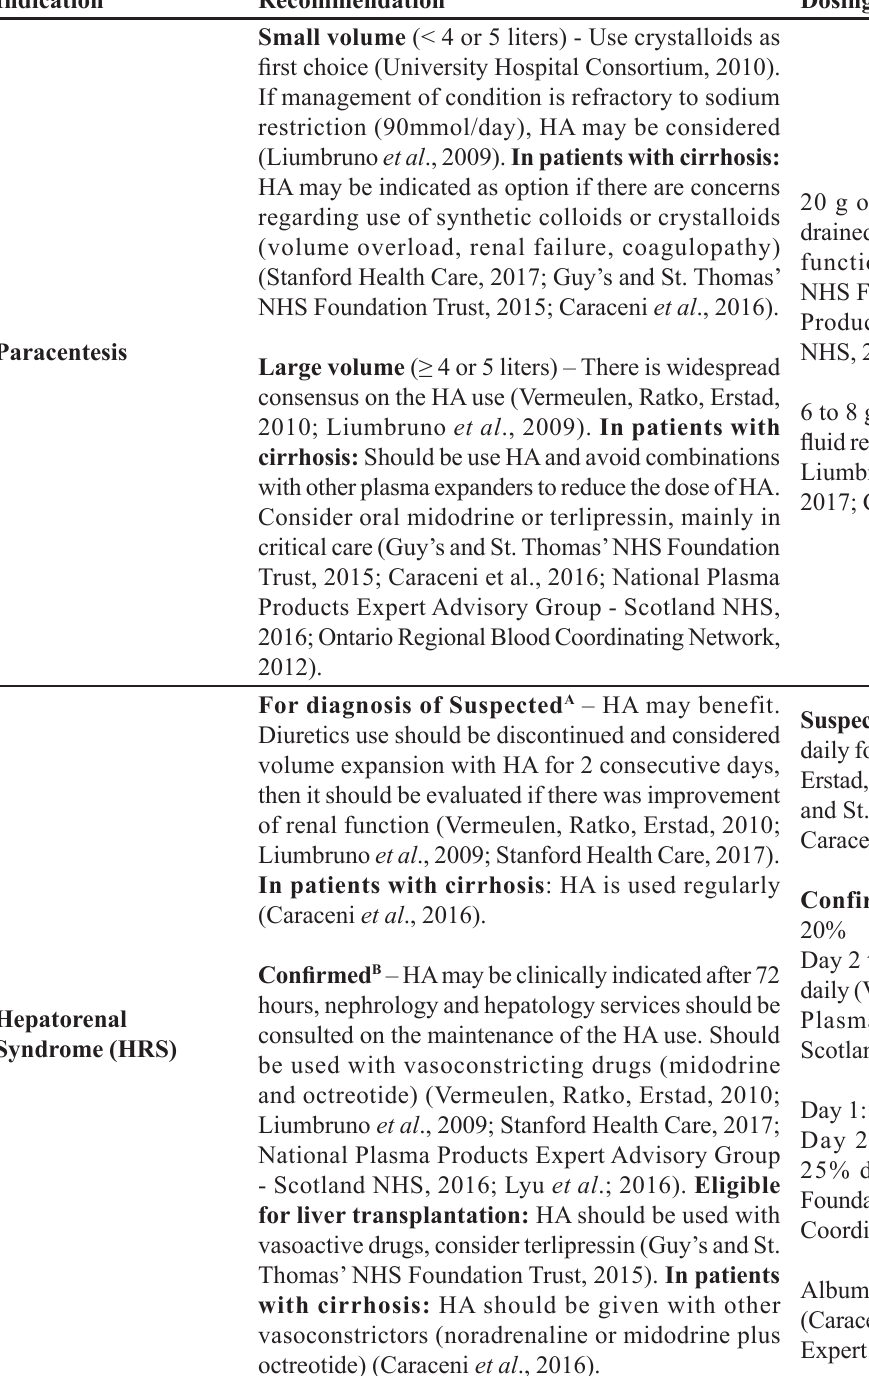
TABLE V - Synthesis of recommendations for human albumin use